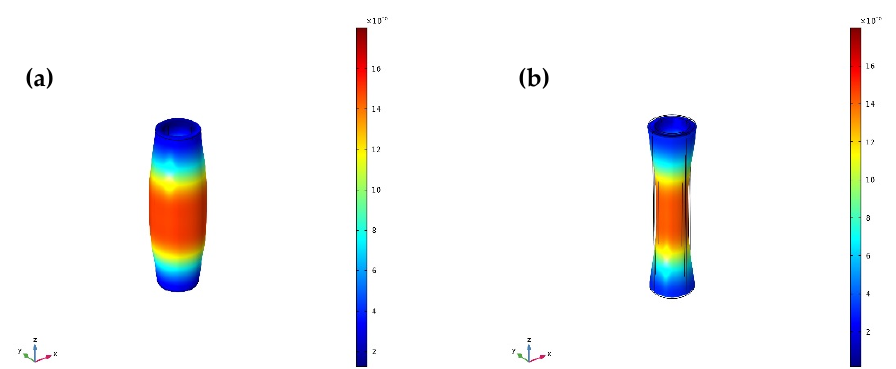
Figure 9. Vibrational mode of the No. 1 transducer with 1 =8 τ at the fundamental mode ( f r 1 = 33,541 Hz): ( a ) expansion; ( b ) shrinkage.